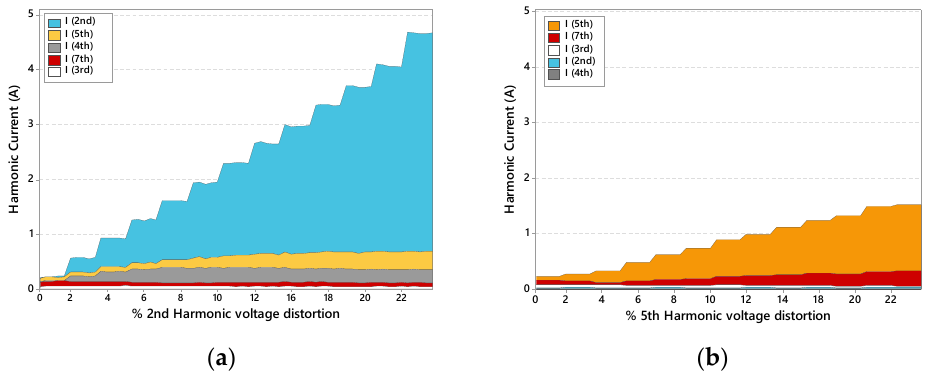
Figure 11. Harmonic currents present in LSPMM in the presence of ( a ) 2nd-order voltage harmonic and ( b ) 5th-order voltage harmonic [13].